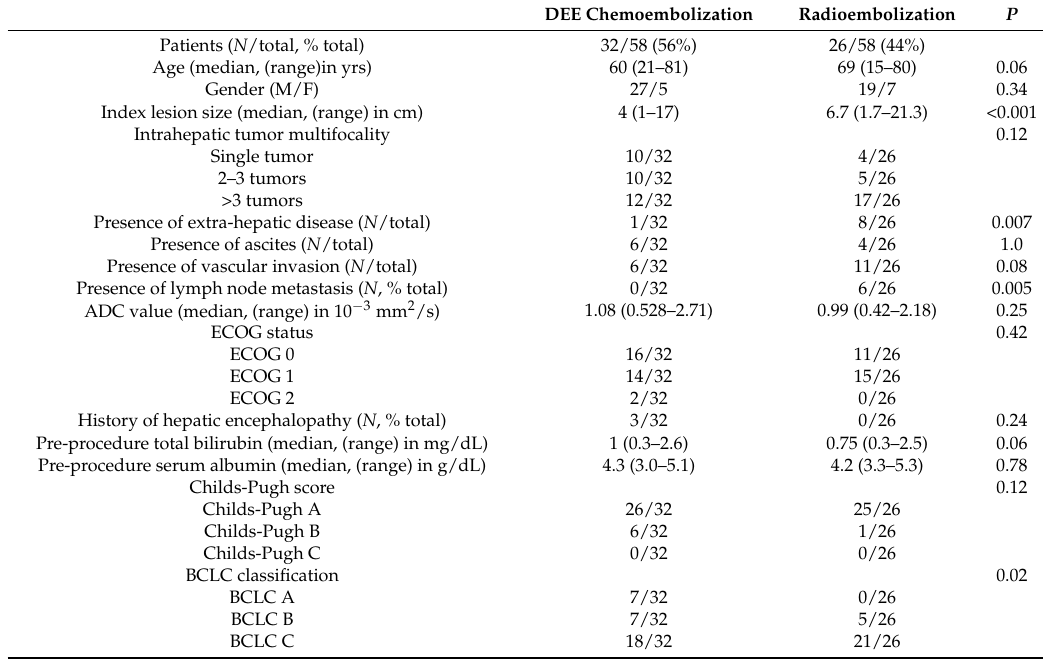
Table 1. Demographics of the study